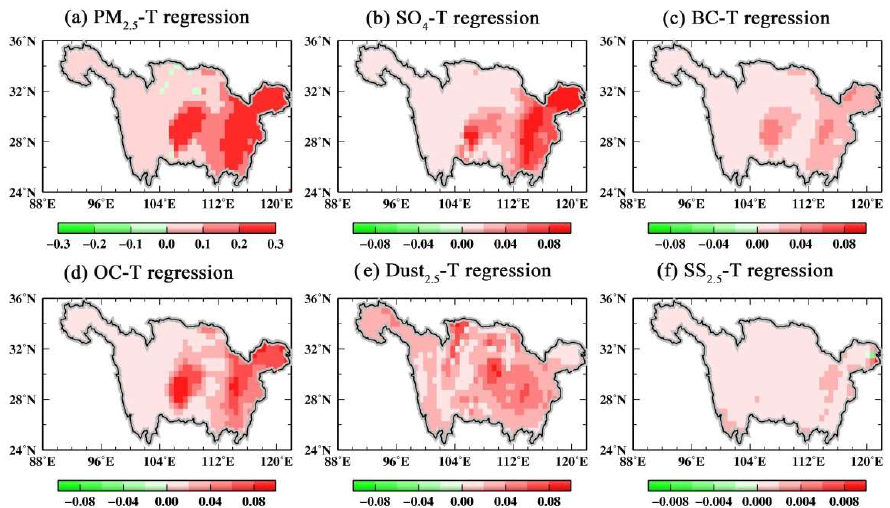
Figure 13. Multiple linear regression coefficients ( β 2 ) of each PM 2.5 component with surface temperature (T), in units of µ g m − 3 K − 1 . ( a – f ) refer to the regression coefficients of PM 2.5 , SO 4 , BC, OC, Dust 2.5 and SS 2.5 with surface temperature, respectively.